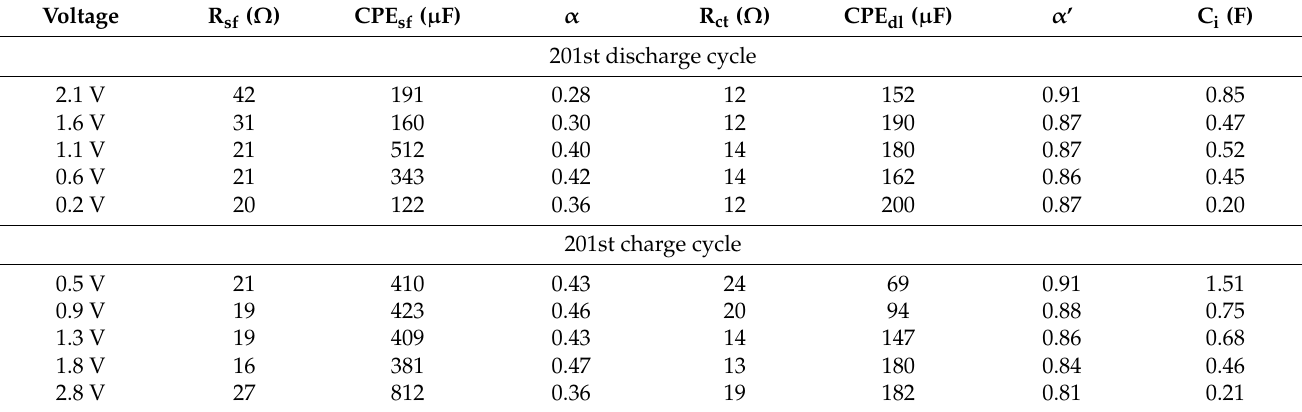
Table 3. EIS fitting results of G-NiFum at different voltages for the 201st